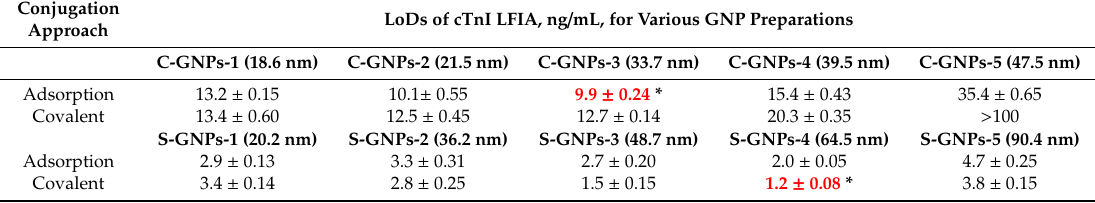
Table 6. LoDs of cTnI detection for LFIAs with di ff erent antibody–GNP conjugates. Conjugation Approach